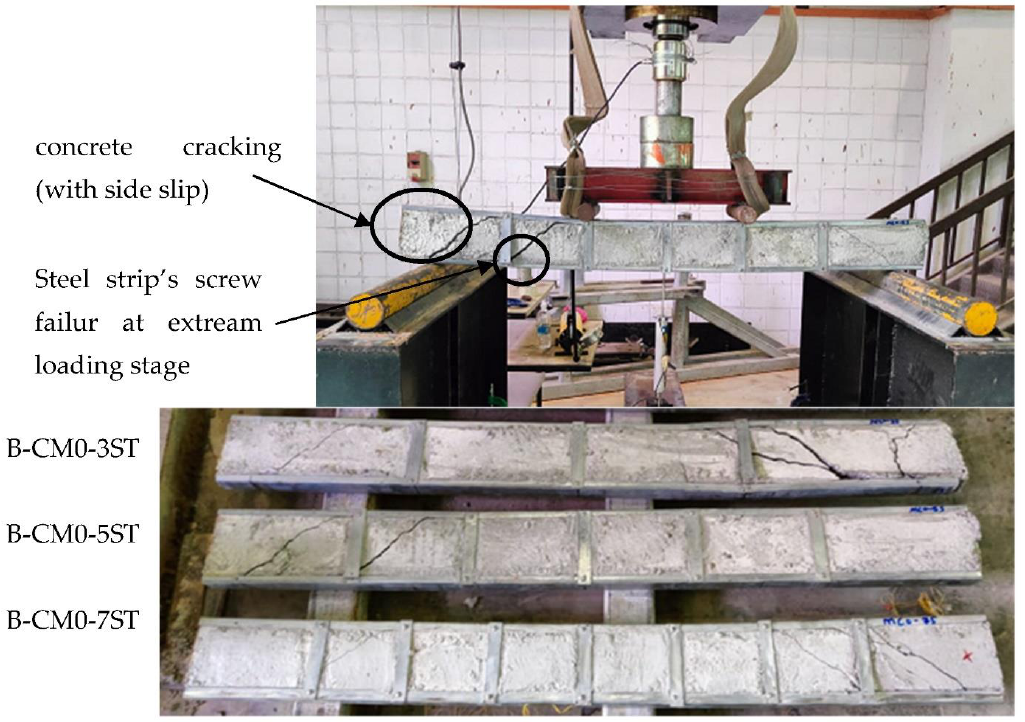
Figure 8. Typical failure modes of stiffened concrete filled specimens with steel strips.